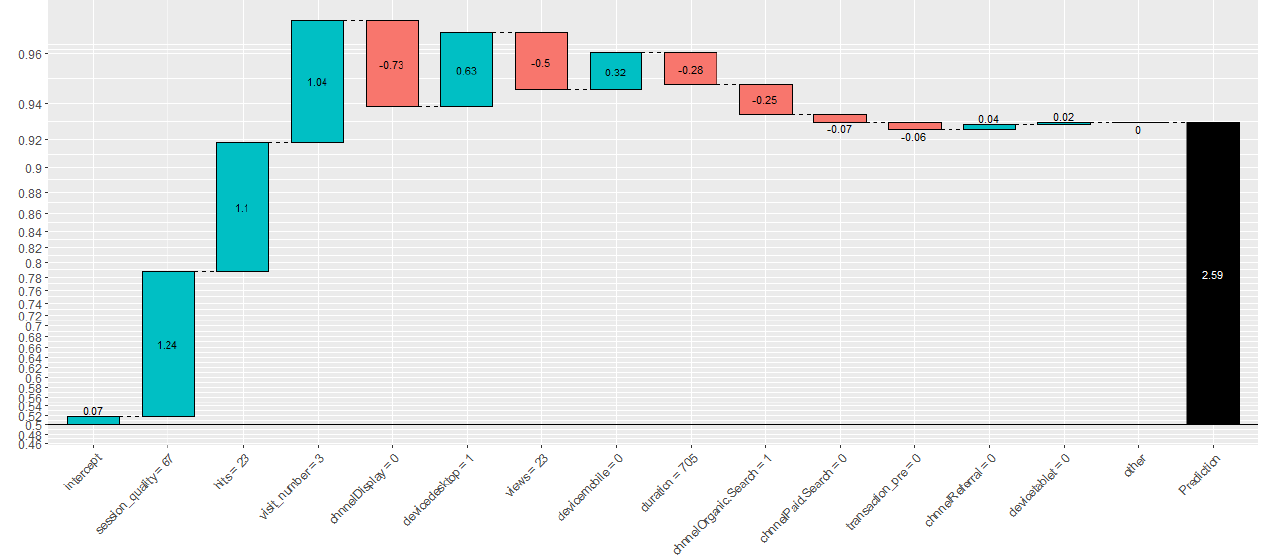
Figure 6. Application of interpretable machine learning.